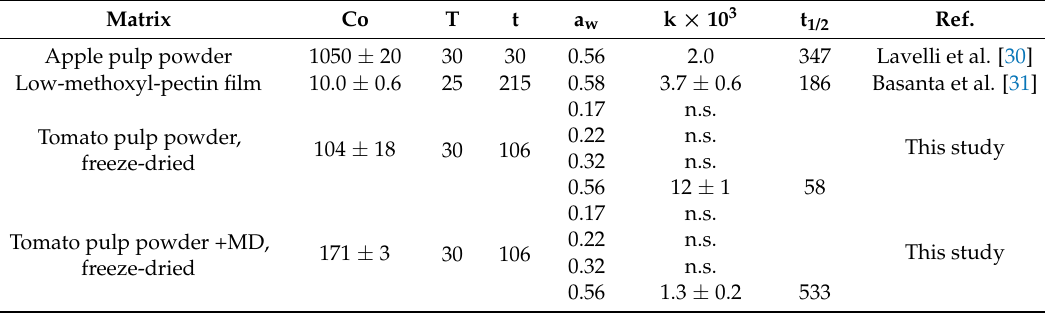
Table 3. Initial concentration (mg/kg dry weight), storage temperature ( ◦ C), time (d), a w ,